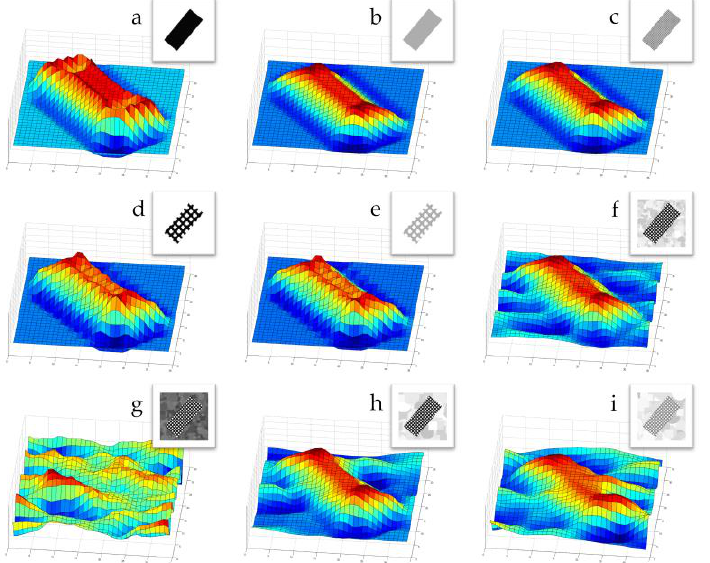
Figure 11. Examples of BBID images convolution. Each panel shows the original BBID image and its convolution; they correspond, respectively, to: ( a ) black-filled bar on white background; ( b ) gray-filled bar (170 #Lum) on white background; ( c ) black textured bar (001 #Lum, 40% “S” texture) on white background; ( d ) black textured bar (001 #Lum, 60% “L” texture) on white background; ( e ) gray textured bar (170 #Lum, 60% “L” texture) on white background; ( f ) black textured bar (001 #Lum, 60%